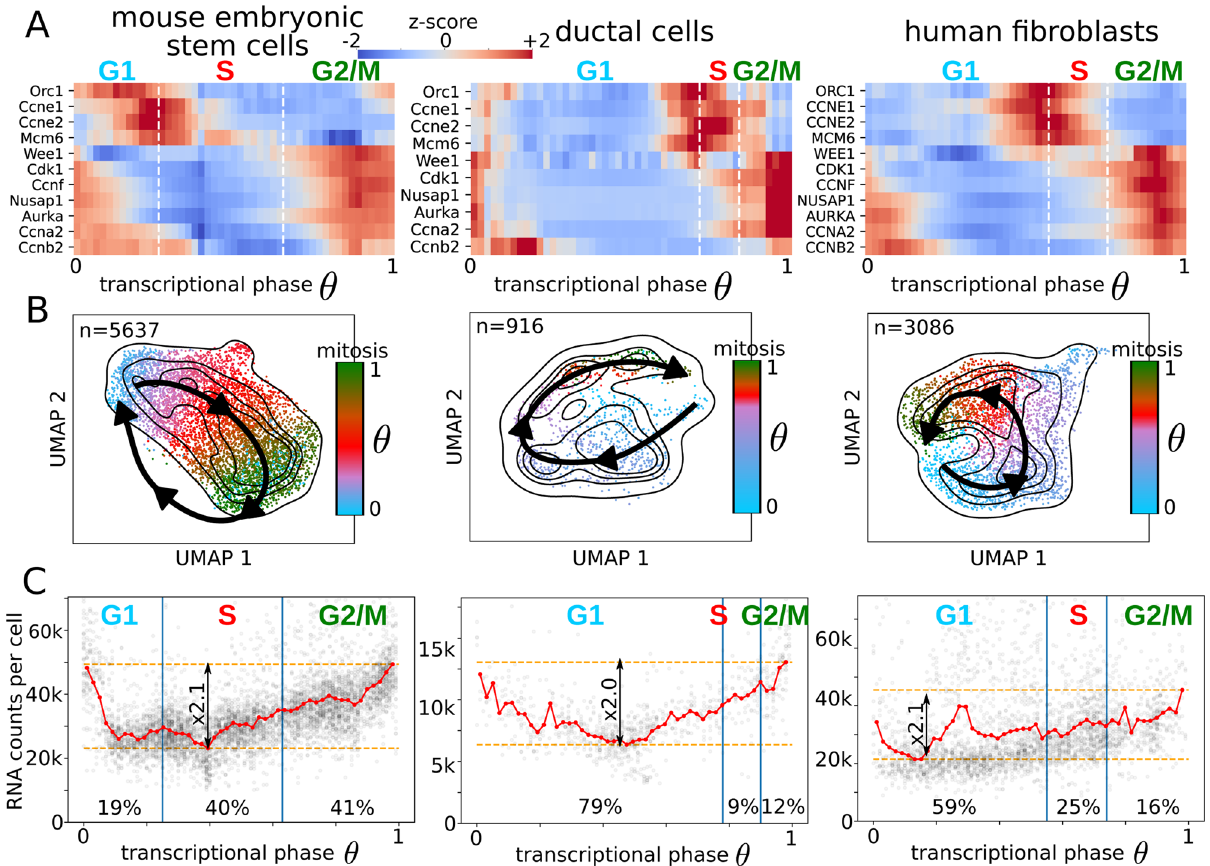
Fig. 3 Cell cycle analysis in mouse and human cellular models. A The transcriptional phases and the cell cycle phases were connected based on marker genes. Z-scores are only intended for comparison purposes, the changes in the expression across the cycle are, in general, highly signi fi cant. B The UMAP embeddings for mESCs, ductal cells, and human fi broblasts with the cell cycle directionality identi fi ed by DeepCycle (black arrows). The cells are associated with different colors depending on the cell cycle phase they belong to, light blue for cells in G1, red in S, and dark green in G2/M. C RNA counts per cell as a function of the transcriptional phase show doubling trends followed by a sudden drop that identi fi es